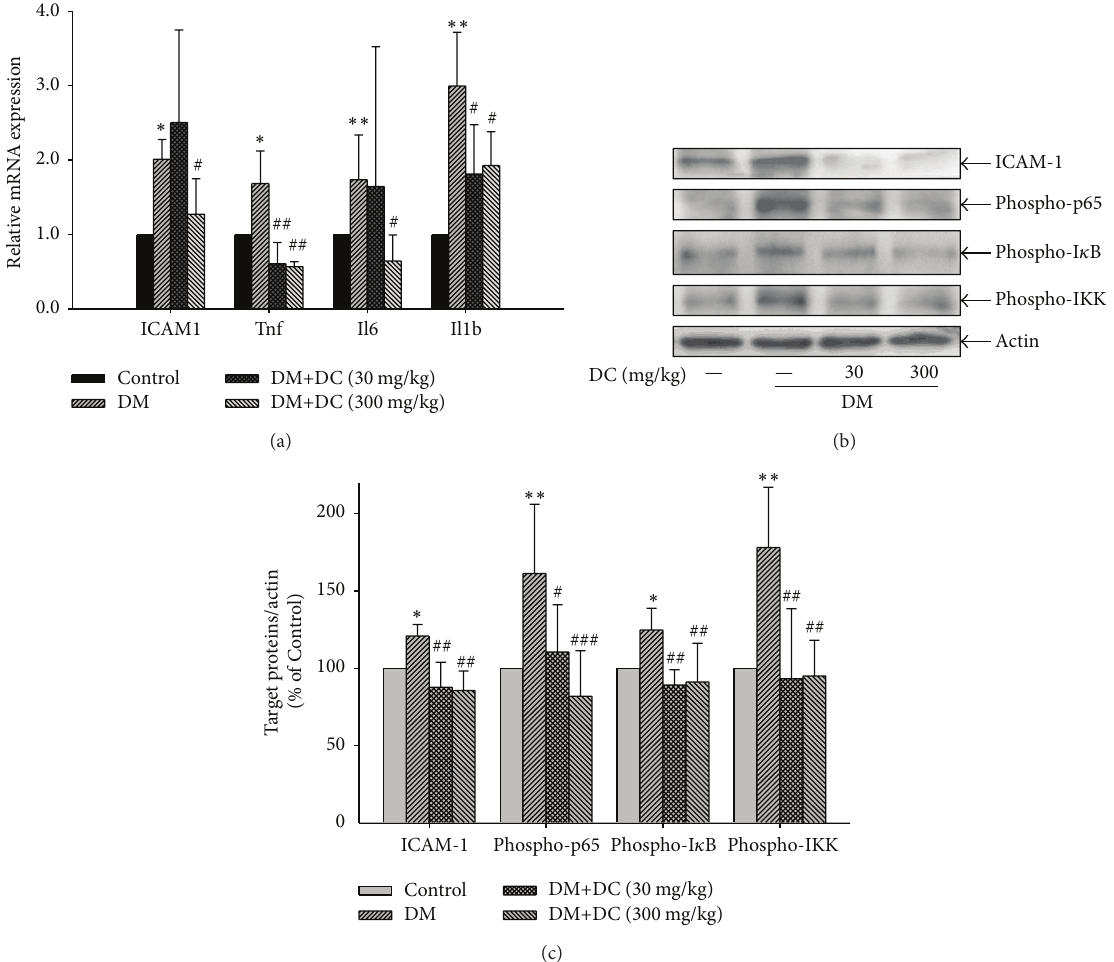
Figure 4: Effects of DC on the expression of ICAM-1, TNF 𝛼 , IL-6, IL-1 𝛽 , and the activation of NF- 𝜅 B signaling pathway. (a) Retinal mRNA expression of ICAM-1 (ICAM1), TNF 𝛼 (Tnf), IL-6 (Il6), IL-1 𝛽 (Il1b). Data are expressed as means ± SD ( 𝑛 = 10 for control, 𝑛 = 7 for DM, 𝑛 = 9 for DM+DC 30mg/kg, and 𝑛 = 8 for DM+DC 300 mg/kg). ∗ 𝑃 < 0.05 , ∗∗ 𝑃 < 0.01 compared to control; # 𝑃 < 0.05 , ## 𝑃 < 0.01 compared to DM without DC. (b) Retinal expression of ICAM-1 and phosphorylated p65, I 𝜅 B, and IKK. ICAM-1 and phosphorylated p65, I 𝜅 B, and IKK are detected by immunoblotting using specific antibody. Results represent at least three repeated experiments. (c) Quantitative densitometric analysis of ICAM-1 and phosphorylated p65, I 𝜅 B, and IKK. Data are expressed as means ± SD ( 𝑛 = 10 for control, 𝑛 = 7 for DM, 𝑛 = 9 for DM+DC 30 mg/kg, and 𝑛 = 8 for DM+DC 300mg/kg). ∗ 𝑃 < 0.05 , ∗∗ 𝑃 < 0.01 compared to control; # 𝑃 < 0.05 , ## 𝑃 < 0.01 , and ### 𝑃 < 0.001 compared to DM without